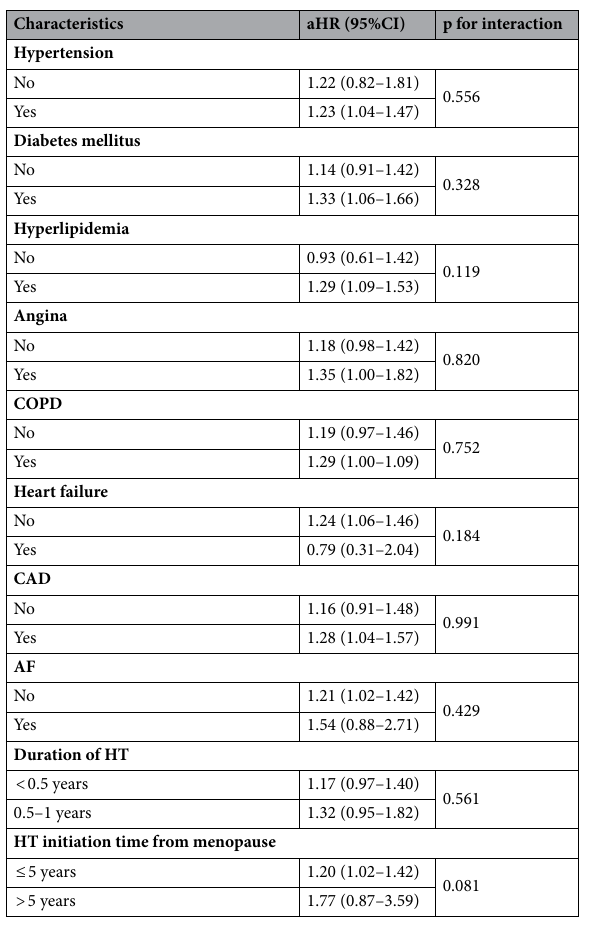
Table 4. Subgroup analysis for ischemic stroke risk between the conjugated equine estrogen and estradiol groups. Cox regression model was adjusted for characteristics listed in Table 1. HR, hazard ratio; COPD, chronic obstructive pulmonary disease; CAD, coronary artery disease; AF, atrial fibrillation; HT, hormone